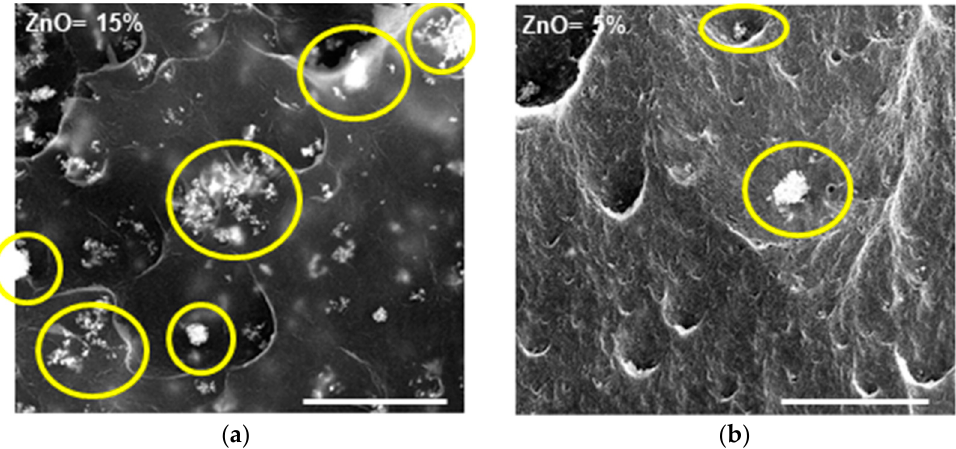
Figure 6. SEM images of the ZnO / s-PS δ -form aerogels with 15 wt% ( a ) and 5 wt% ( b ) of ZnO. Some ZnO aggregates are indicated by yellow circles (scale bar: 50 µm).